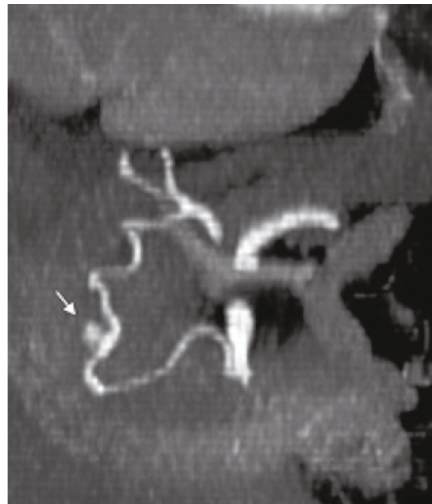
Figure 2: Maximum intensity projection (MIP) image showing a focus of active bleeding (arrow) from the vascular arcade running along the mesenteric side of the duodenal c-loop. This was initially thought to represent the pancreaticoduodenal arcade but was found to be an arc of Buhler during angiography. Fusiform dilatation at the site of the active bleeding could be appreciated.